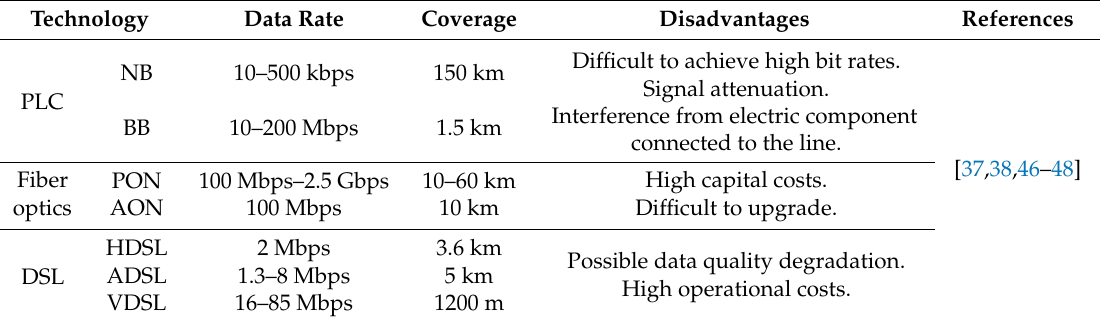
Table 1. Comparison of different wired technologies for M2M